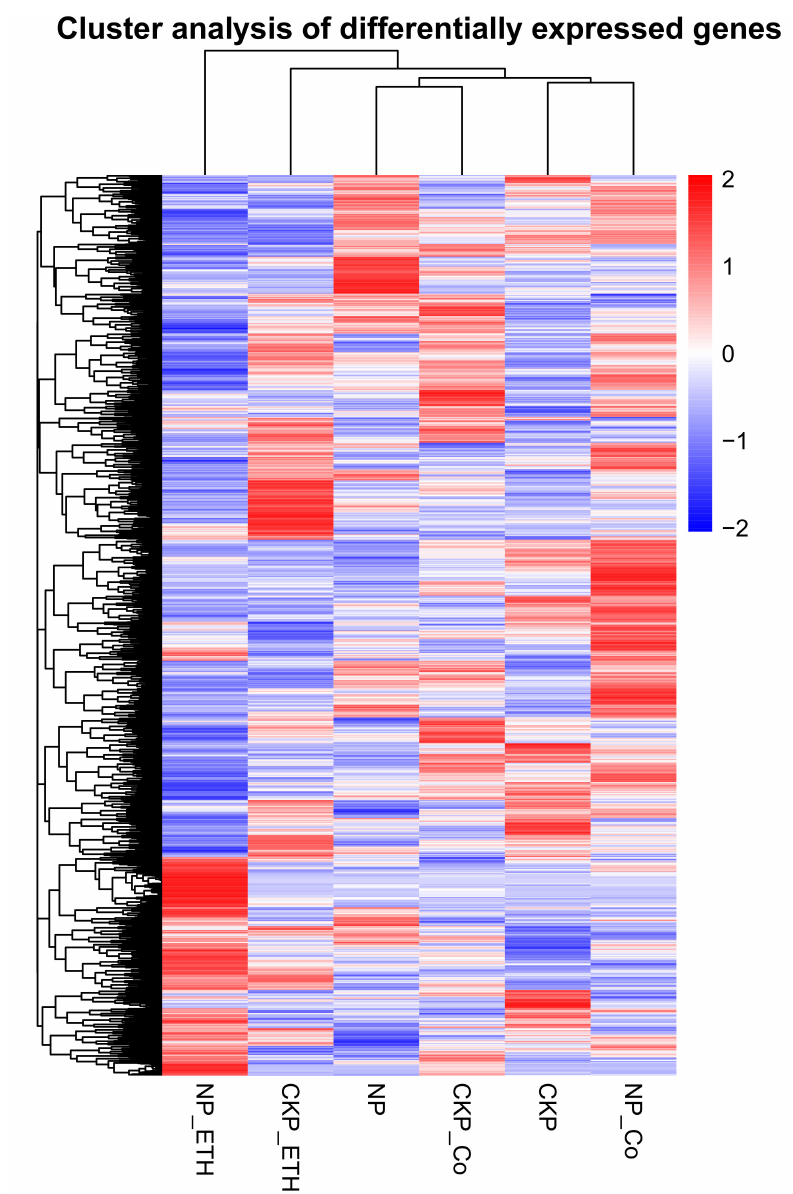
Figure 5. Gene cluster analysis among different treatments, namely CKP (normal phosphate (Pi)), NP (Pi starvation), CKP_ETH (normal Pi and ethephon), CKP_Co (normal Pi and CoCl 2 ), NP_ETH (Pi starvation and ethephon), NP_Co (Pi starvation and CoCl 2 ). The abscissa represents the group name, and the color represents the degree of expression. Red indicates high expression genes, blue indicates low expression genes, and red to blue indicates log10(FPKM+1) from large to